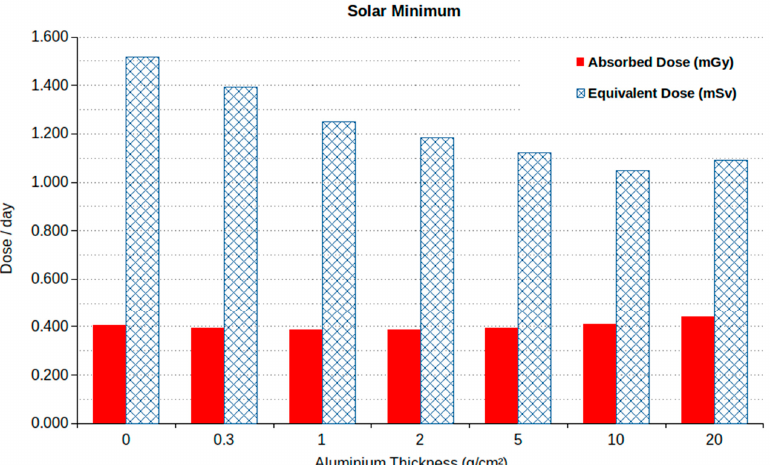
Figure 2. Absorbed and equivalent doses (in mGy/day and mSv/day, respectively) at solar minimum as a function of Al shielding thickness. (The error bars are not visible because the relative error is below 1%.)